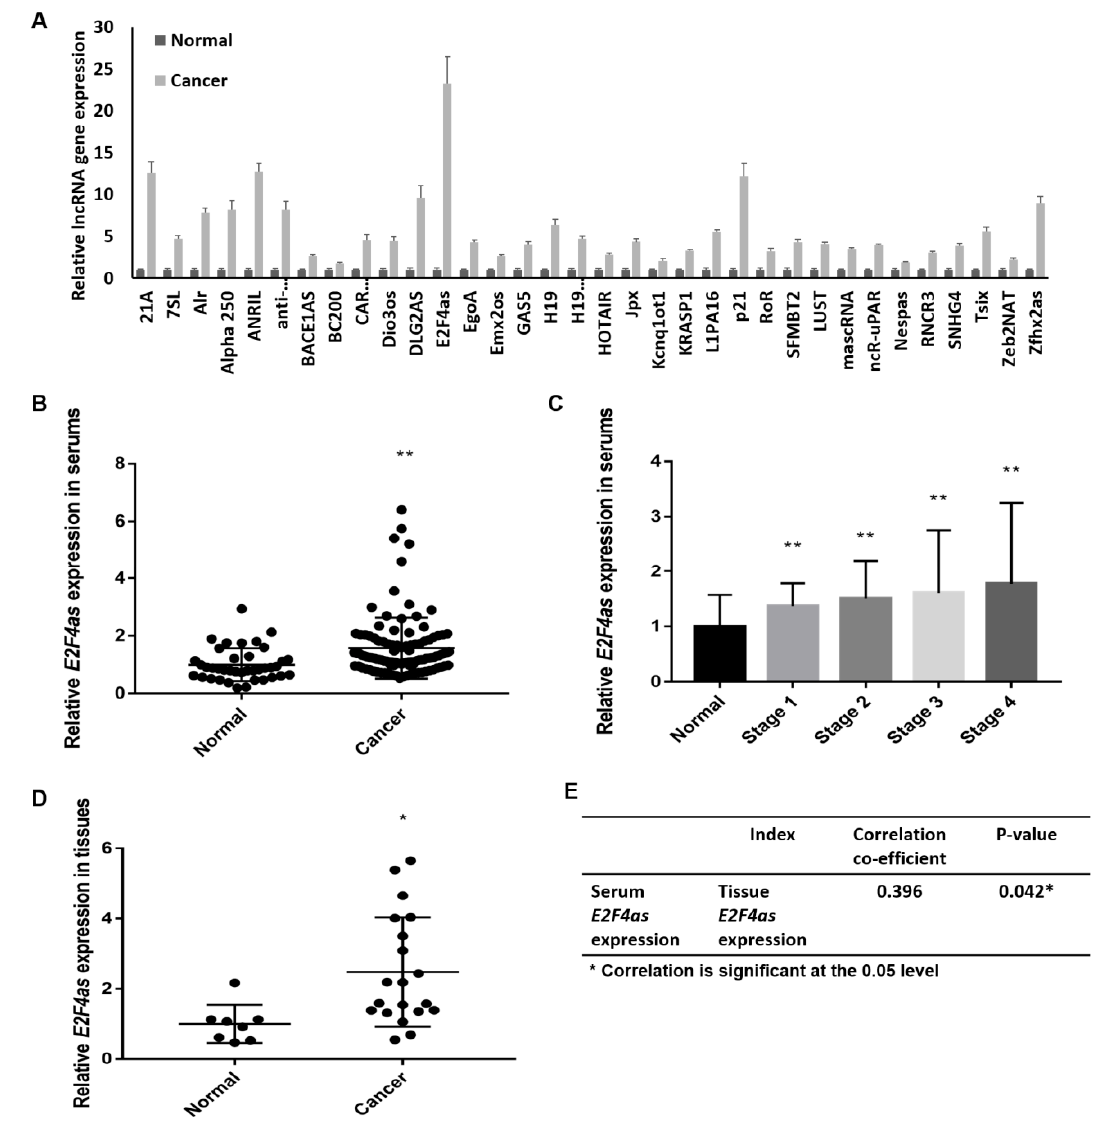
Figure 1. Expression of lncRNA E2F4as in the serum of ovarian cancer patients. ( A ) LncRNAs profile in ovarian patient samples identified by qRT-PCR in the serum of 38 ovarian cancer patients and 8 normal patients; ( B ) Expression of lncRNA E2F4as was measured by qRT-PCR technology in the serum of 108 ovarian cancer patients and 32 normal patients; ( C ) Expression of lncRNA E2F4as in the serum of ovarian cancer patients per cancer stage detected using qRT-PCR in 108 ovarian cancer patients and 32 normal patients; ( D ) Expression of lncRNA E2F4as was measured using qRT-PCR technology in the tissues of 20 ovarian cancer patients and 8 normal patients; * p < 0.05, ** p < 0.01 vs. normal. ( E ) Correlation between E2F4as gene expression in the serum and tissue clinical induce; * p < 0.05. 2.2. E2F4as Levels Elevated in Patient Serum with Ovarian Cancer Having Poor